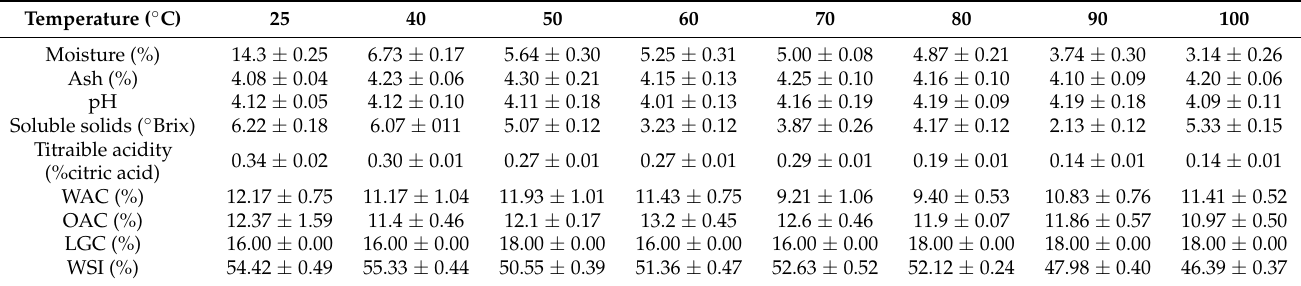
Table 1. Physicochemical and functional properties of eight temperatures of treatment of argan pulp powder.